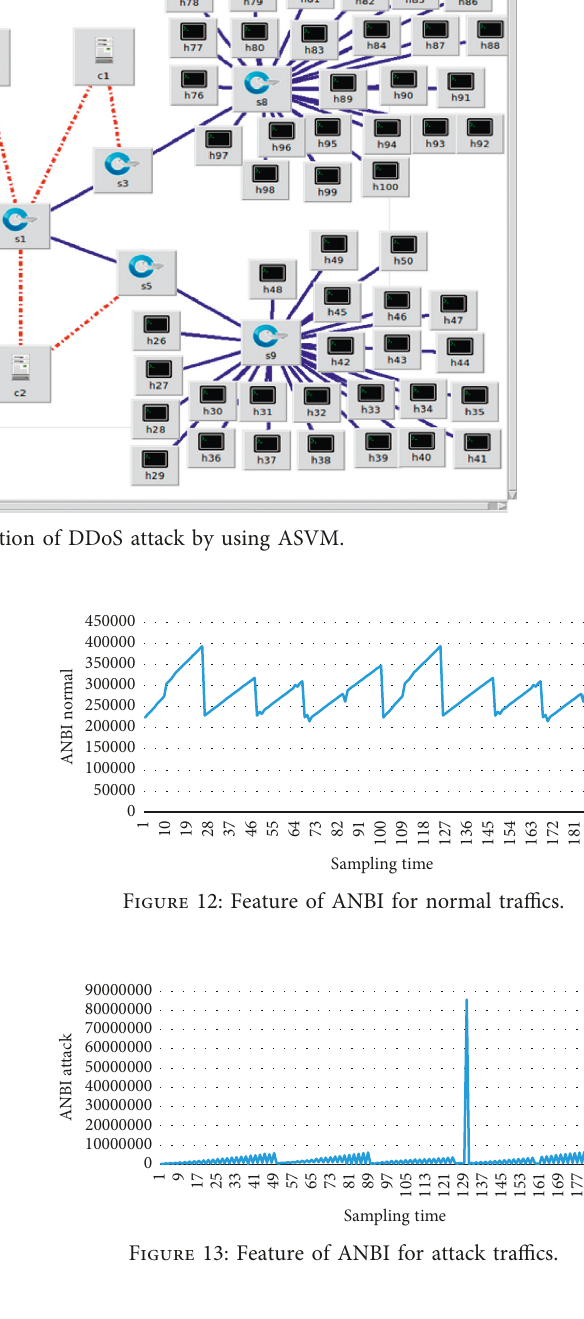
Figure 11: Feature of ANPI for attack traffics.